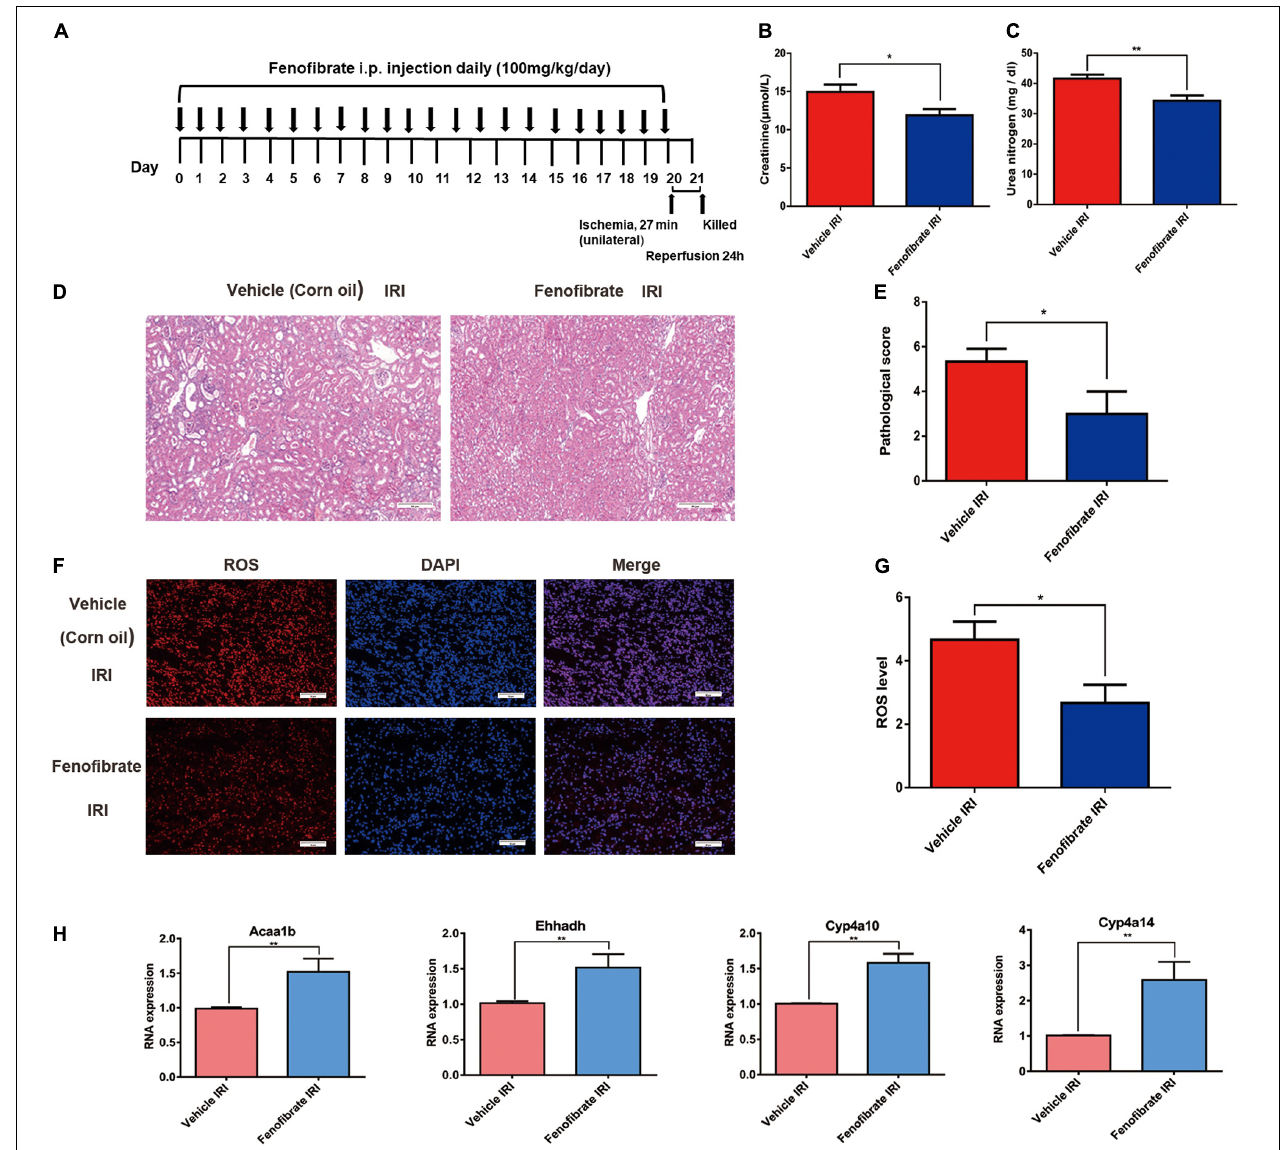
FIGURE 4 | Fenofibrate reverses renal tubular injury caused by a decrease in lipid metabolism gene expression and the accumulation of reactive oxygen species mediated by SHP-1 insufficiency in mice with ischemia-reperfusion injury. (A) Schematic diagrams of the experimental procedure. (B,C) Levels of creatinine and urea nitrogen in Ptpn6 + / mev mice given fenofibrate and vehicle control (corn oil). (D,E) H and E staining in the kidneys of Ptpn6 + / mev mice given fenofibrate and in those given vehicle control after IRI; the quantitative results are shown. Scale bars = 50 µ m. (F,G) Accumulation of ROS levels in the kidneys of Ptpn6 + / mev mice given fenofibrate and in those given vehicle after IRI; the quantitative results are shown. Scale bars = 50 µ m. (H) Expression of Acaa1b , Ehhadh , Cyp4a10 , and Cyp4a14 in Ptpn6 + / mev mice given fenofibrate and in those given vehicle control after IRI. * p < 0.05, ** p <